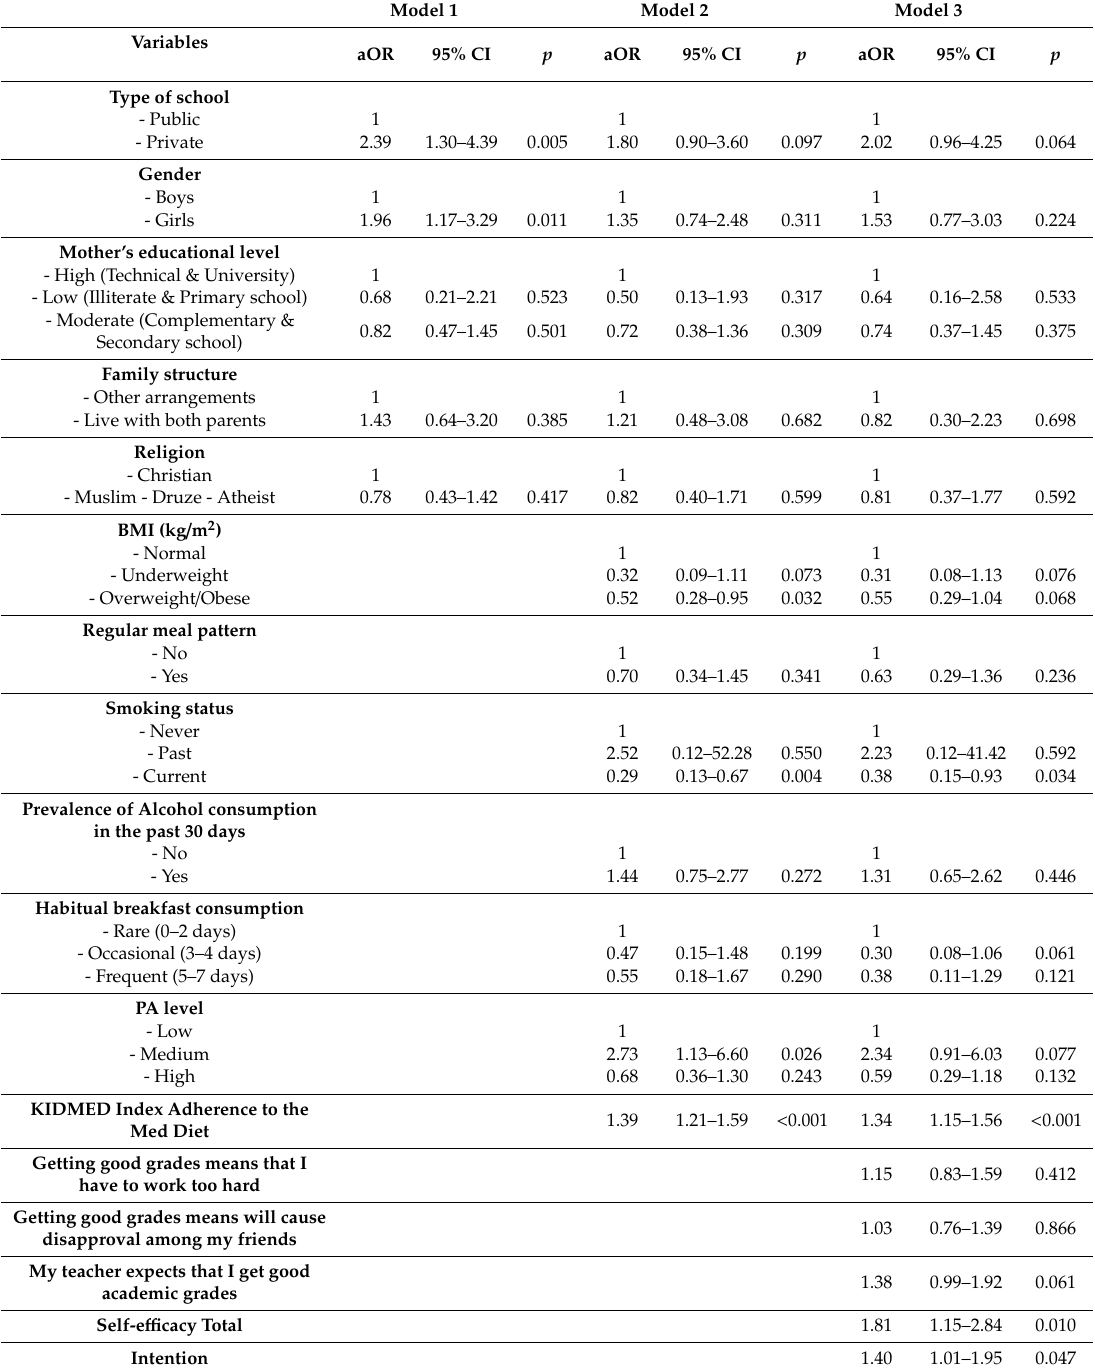
Table 4. Association of Socio-demographics, Health Behaviors, Socio-cognitive Factors with Academic Achievement in Lebanese